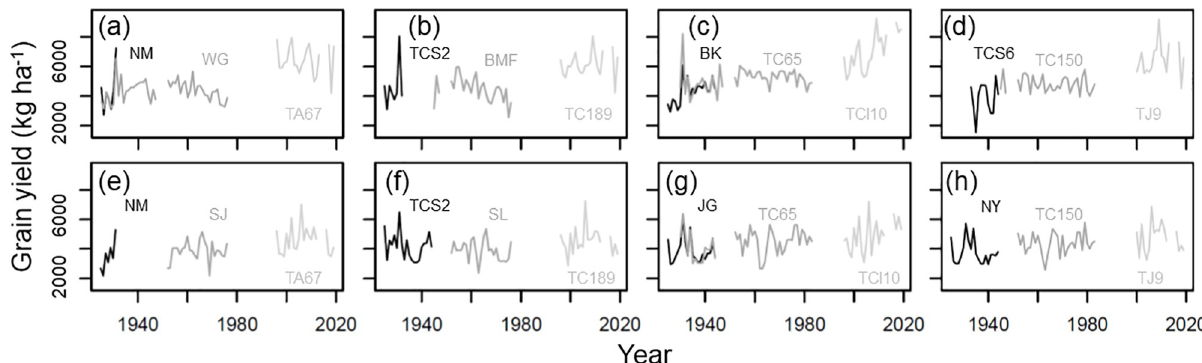
Fig 1. Yearly variation in grain yield and cultivation period for twelve rice cultivars in cool (a, b, c, and d) and warm (e, f, g, and h) cropping seasons.